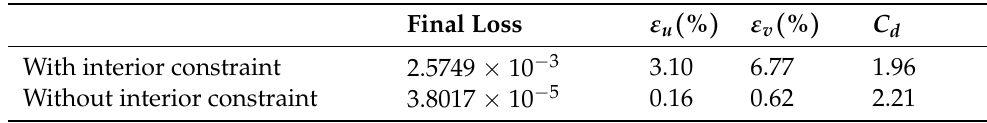
Table 3. Final loss, velocity error and drag coefficient obtained in IB-PINNs with and without the interior force compactness constraint.